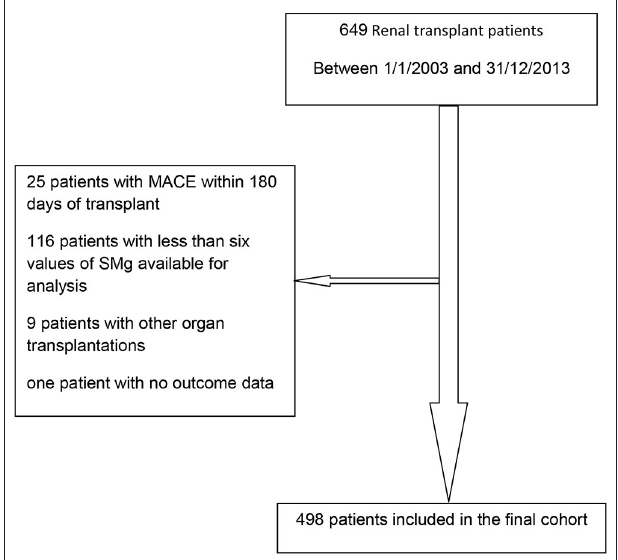
FIGURE 3 | Flow diagram of the recruitment and exclusion of patients in the